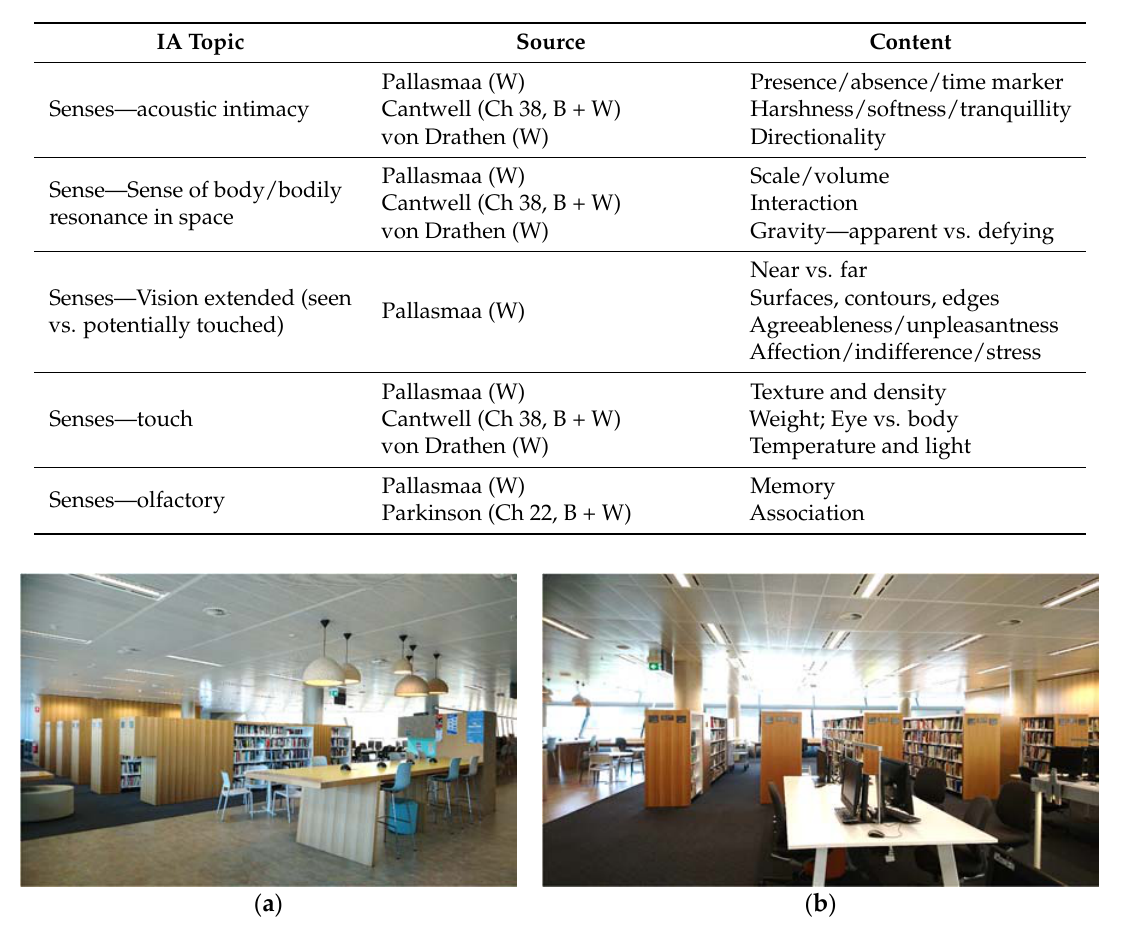
Table 1. Selected preliminary content analysis of selected key texts—senses.